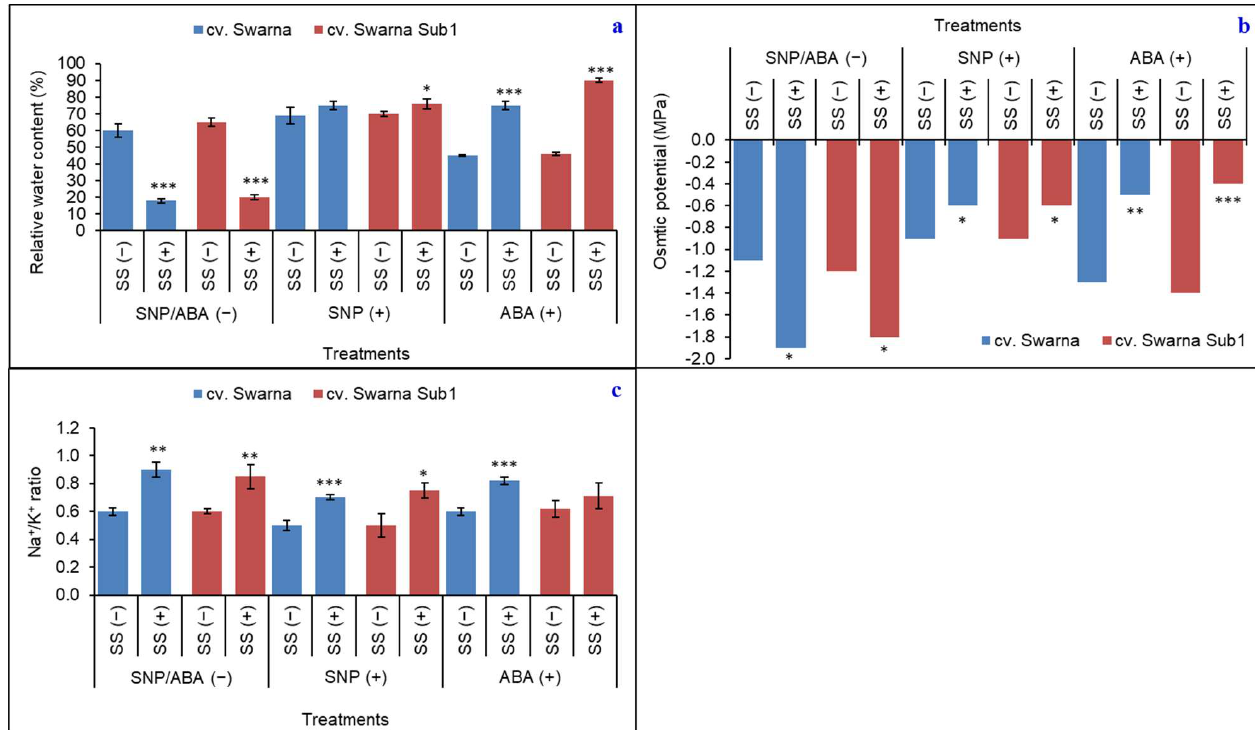
Figure 3. Changes in relative water content ( a ), osmotic potential ( b ) and Na + /K + ( c ) in two rice genotypes (cv. Swarna and Swarna Sub1) under salinity stress [SS (+)] and non-salinity stress [SS ( − )] for 72 h with [SNP (+) or ABA (+)] or without [SNP/ABA (−)] priming for 24 h. Data are presented in bars with mean ± SE ( n = 3) from independent experimental sets and the significant values are represented as * ( p ≤ 0.05), ** ( p ≤ 0.01) and *** ( p ≤ 0.001) by student’s t -test to denote the significant difference between SS (−) and SS (+) of SNP/ABA (−) as well as SNP (+) and ABA (+) of each rice genotype.